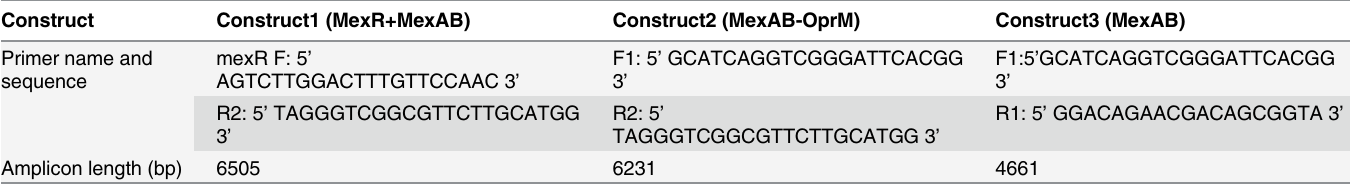
Table 1. Details of primers used for cloning of efflux pump